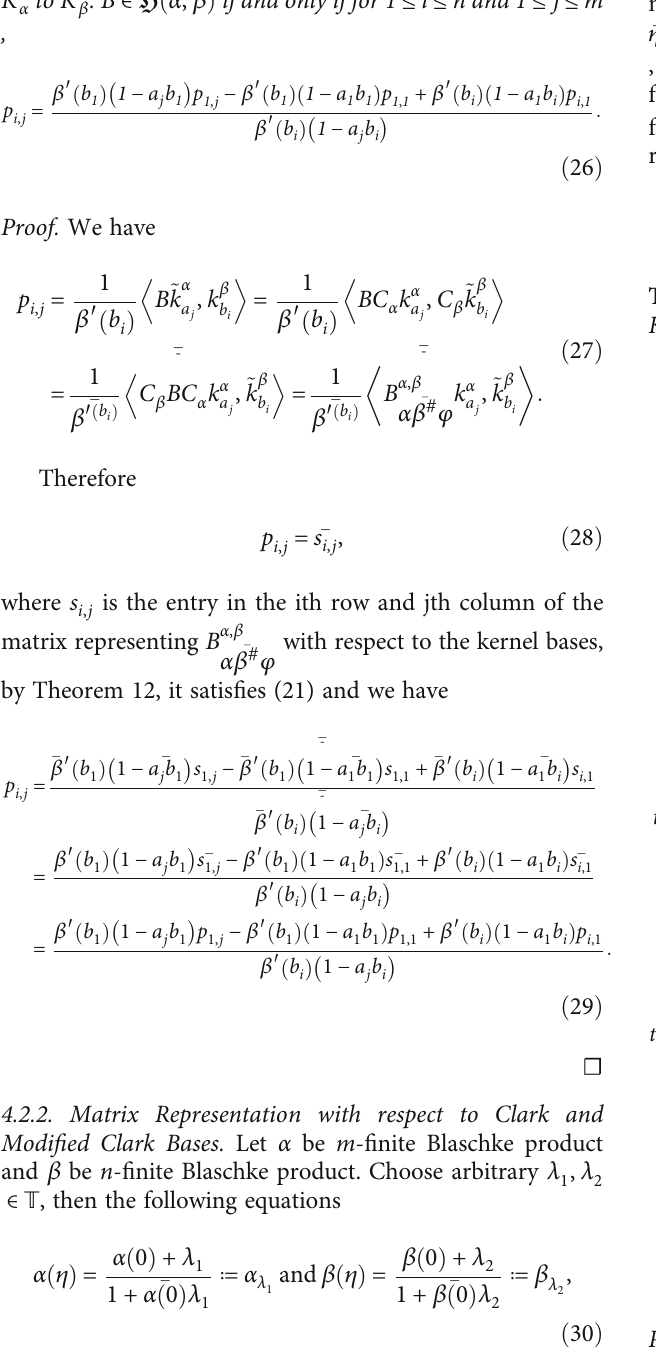
ffiffiffiffiffiffiffiffiffiffiffiffiffiffiffiffi (cid:12) (cid:12) (cid:12)q ffiffiffiffiffiffiffiffiffiffiffiffiffiffiffiffi β ′ ζ (cid:12) α ′ η ð Þ (cid:12) (cid:12) 1 ffiffiffiffiffiffiffiffiffiffiffiffiffiffiffiffiffi (cid:3) (cid:4)(cid:12) α ′ η (cid:12) (cid:12) j